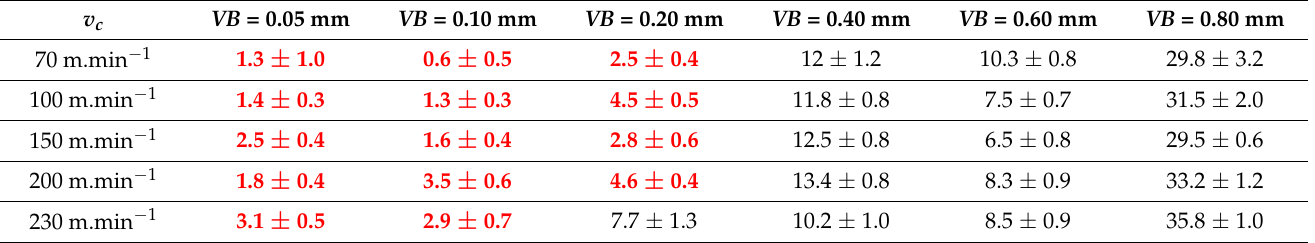
Table 4. Thickness of HAZ as a function of cutting speed and flank wear VB (thickness of HAZ in μ m).